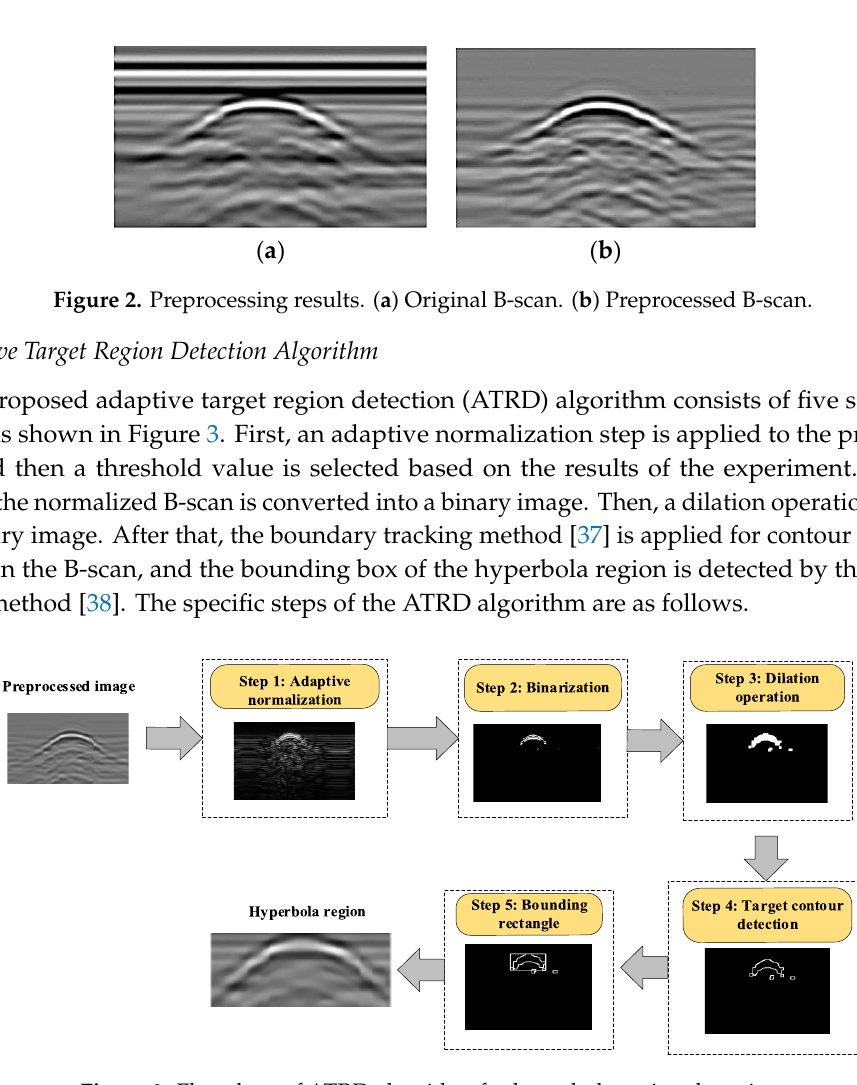
Figure 3. Flowchart of ATRD algorithm for hyperbola region detection.